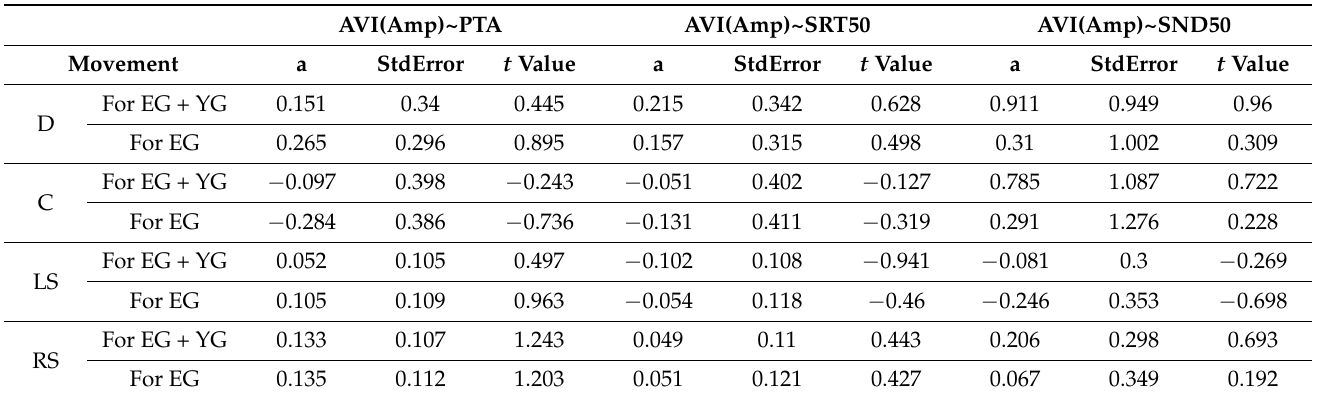
Table A3. Relations between AVI(Amp) and